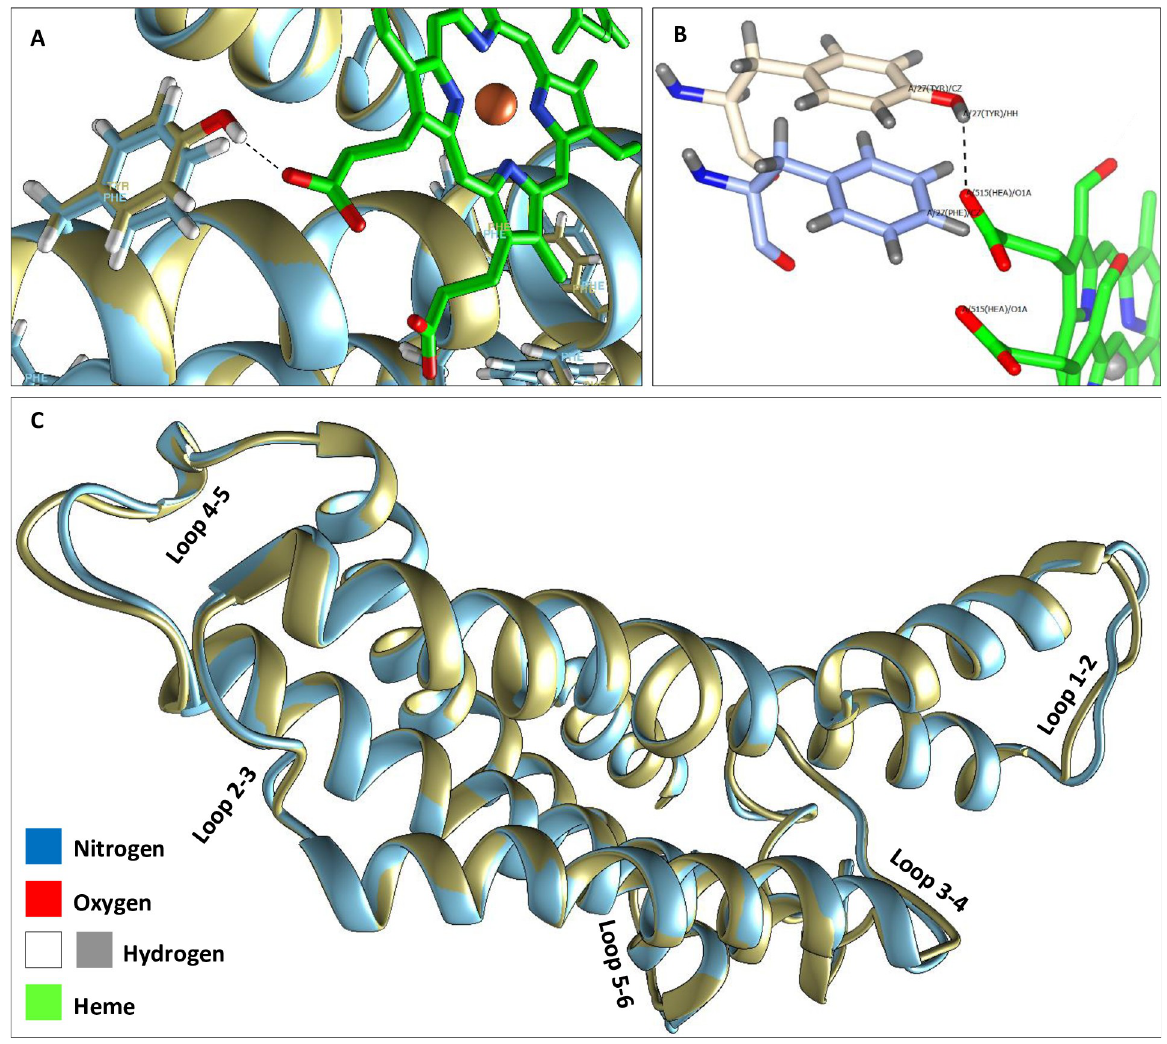
Fig 4. Alignment of the predicted three-dimensional structures of COI proteins of Batrachedra amydraula and Camponotus maculatus . A indicates the occurrence of a hydrogen bond between tyrosine of the first insect at position 38 and Heme 515, while lack of bonding between phenyl alanine of the second insect at the same position. B indicates the side chain structures of the two AAs facing Heme 515. C indicates the alignments of the six helices and five loops of the two 3D structures.